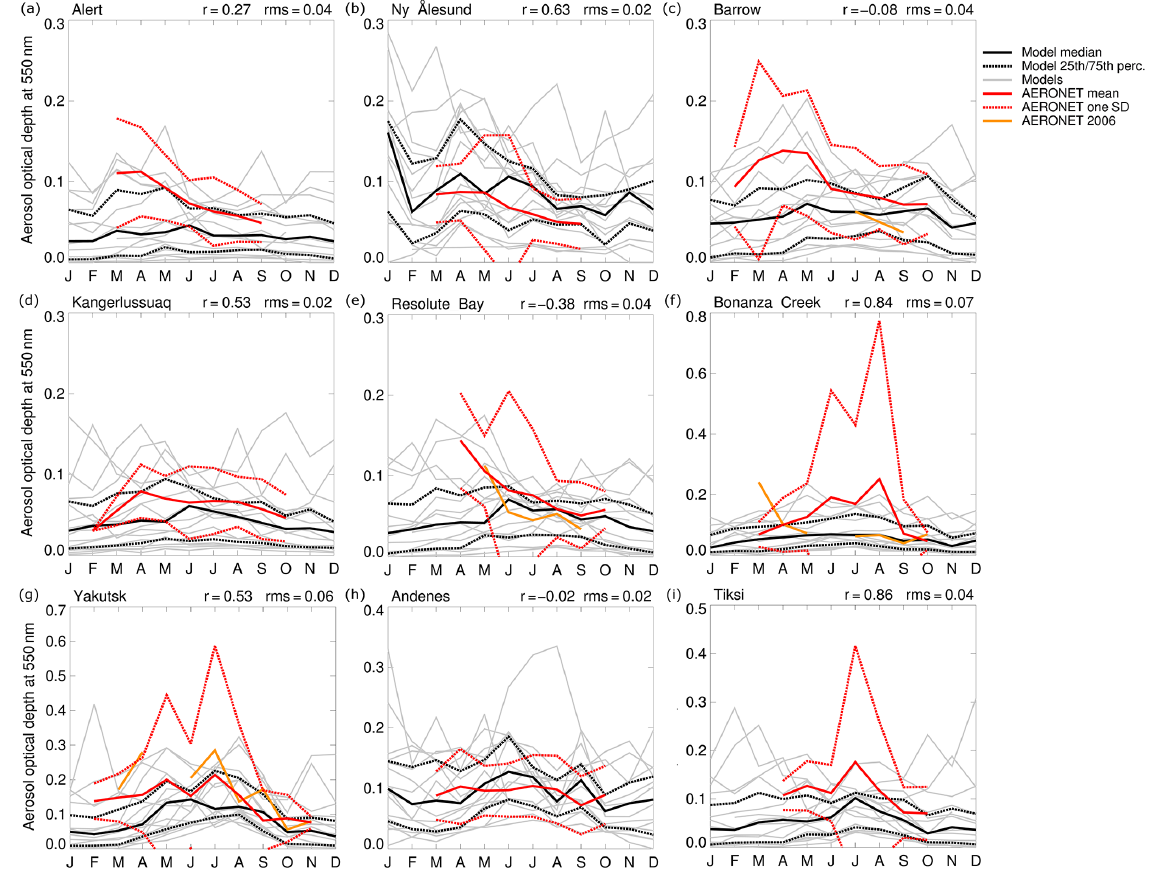
Figure 2. Seasonal cycle of model-median AOD compared to observations for nine Arctic stations: (a) Alert (82 ◦ N, 62 ◦ W), (b) Ny-Ålesund (78 ◦ N, 11 ◦ E), (c) Barrow (71 ◦ N, 156 ◦ W), (d) Kangerlussuaq (66 ◦ N, 50 ◦ W), (e) Resolute Bay (74 ◦ N, 94 ◦ W), (f) Bonanza Creek (64 ◦ N, 148 ◦ W), (g) Yakutsk (61 ◦ N, 129 ◦ E), (h) Andenes (69 ◦ N, 16 ◦ E), and (i) Tiksi (71 ◦ N, 128 ◦ E). The black solid line is the model median and the black dashed line is the 25th / 75th percentile. Models are shown in thin, grey lines. The red solid line is the observational mean and the dashed red line is 1 SD from mean values. Measurements for (a–c) are taken Stone et al. (2014), (d–i) are from AERONET stations. Yellow lines are AOD measurements for the year 2006 (only available at a few